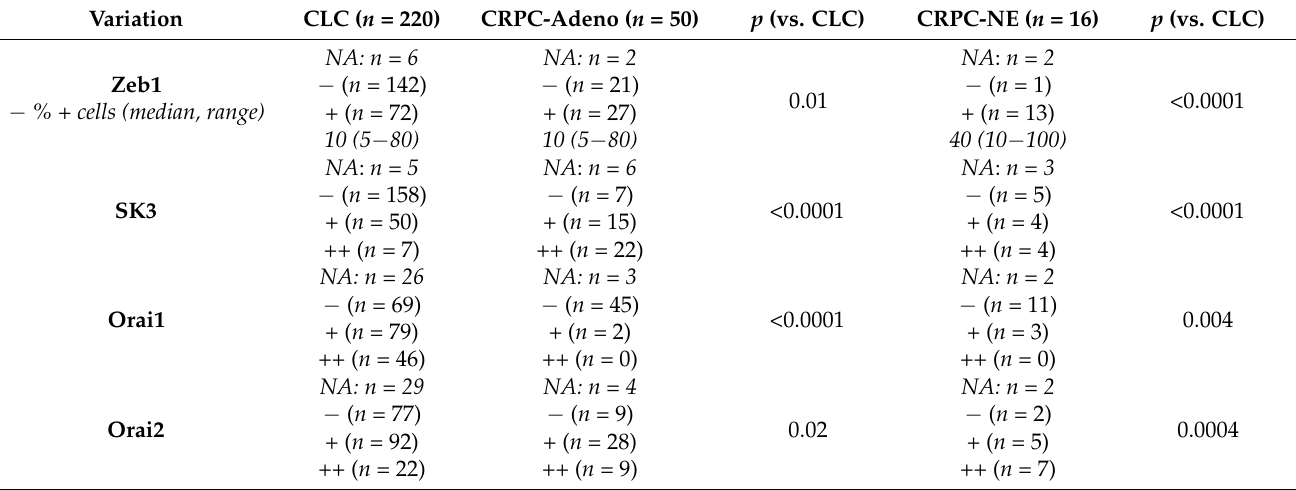
Table 1. Expression of Zeb1, SK3, Orai1 an Orai2 in prostate tissues (CLC: hormone naïve clinically-localized cancer; CRPC: Castration-resistant Prostate Cancer, adeno: adenocarcinoma; NE: neuroendocrine; NA: Not available.).